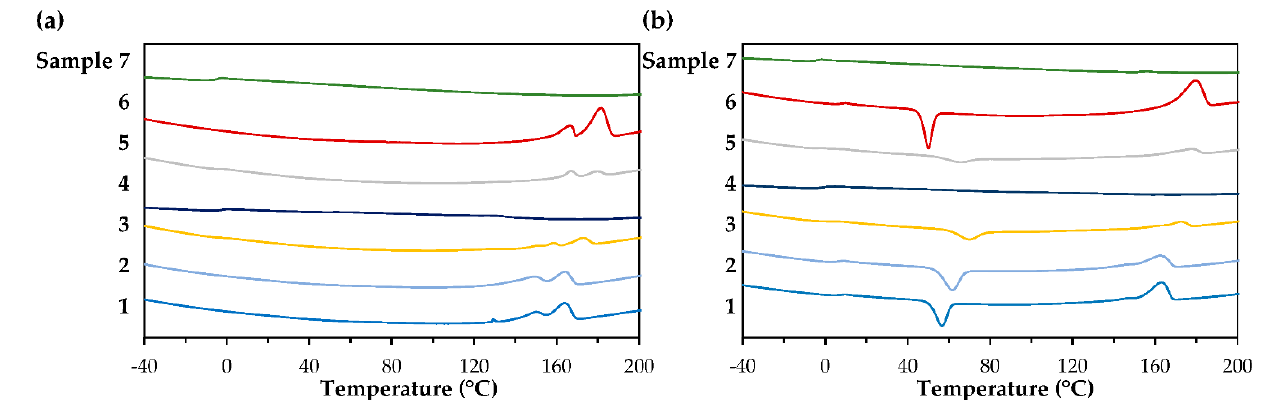
Figure 6. DSC thermogram of Samples 1 (3M2MP 5.5 mol%), 2 (10.1 mol%), 3 (34.2 mol%), 4 (53.9 mol%), 5 (54.8 mol%), 6 (10.7 mol%), and 7 (100 mol%). ( a ) 1st heating scan; ( b ) 2nd heating scan.